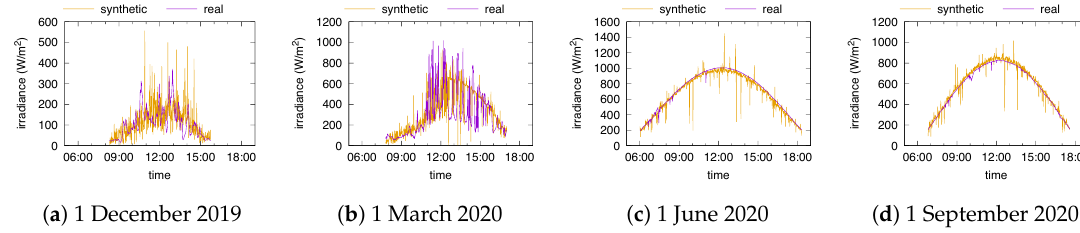
Figure 10. Global irradiance in Portland: measured and synthetic (16 types and 12 intervals).